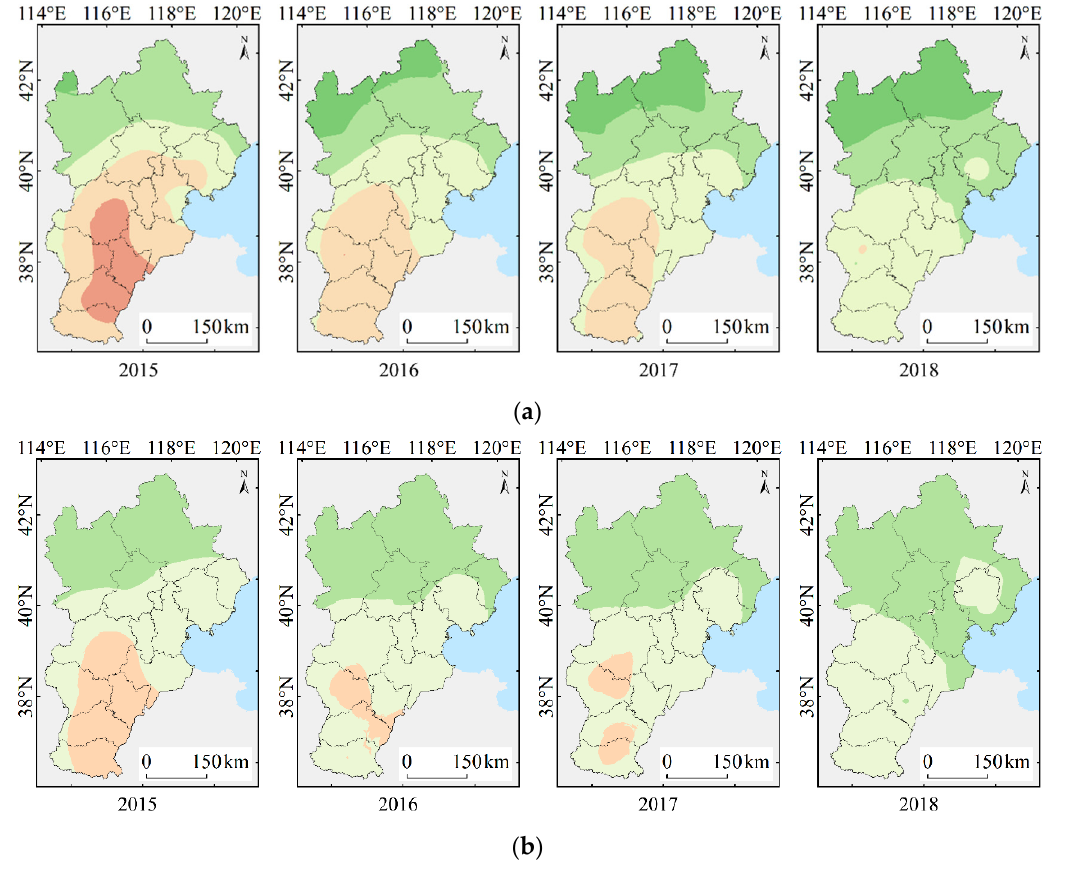
Figure 3. Spatial distribution of the annual mean values of PM 2.5 ( a ) and PM 10 ( b ) concentrations. In 2015, the highest annual average PM 2.5 concentration reached Level 6 and was mainly distributed in southern cities of the BTH region, accounting for 14.7% of the total area. Nearly half of the experimental region had concentrations exceeding the Level 2 limit, and regions with Level 4, 3 and 2 concentrations accounted for 20.7%, 30.2% and 1.1%, respectively, of the total area. Compared to 2015, the annual average concentration decreased significantly in 2016; the areas with Grade 5 and 6 concentrations in the south shrank rapidly. In addition, areas with annual average concentrations exceeding the Grade 2 limit decreased to 31.9%, while the areas with Grade 4, 3 and 2 concentrations sequentially expanded towards the south, accounting for 30.0%, 26.0% and 12.1%, respec ‐ tively, of the total area. In 2017, the Level 5 concentration range contracted slightly, with an annual average concentration of 23.5% in the area, exceeding the Level 2 limit, and the areas of Level 4, 3 and 2 concentrations continued to expand southwards, accounting for 32.0%, 26.2% and 18.3%, respectively, of the area. In 2018, the annual average concentra ‐ tion declined considerably, and the areas of Grade 4, 3 and 2 concentrations continued to expand from north to south, with the corresponding areas accounting for 41.8%, 33.6% and 24.4%, respectively, of the total area. However, most of these areas exhibited excellent and good air quality conditions. In 2015, the highest annual average PM 10 concentration reached Level 5, which ex ‐ ceeded the secondary limit of the national standard and was concentrated in the south, accounting for 24.0% of the total area. The lowest level was Level 3, which was largely distributed in the northern part of the study area, accounting for 33.1% of the area. The remaining areas, accounting for 42.9% of the total area, had Level 4 concentrations. In 2016, the Level 5 concentration range contracted, and the Level 2 limit was exceeded in